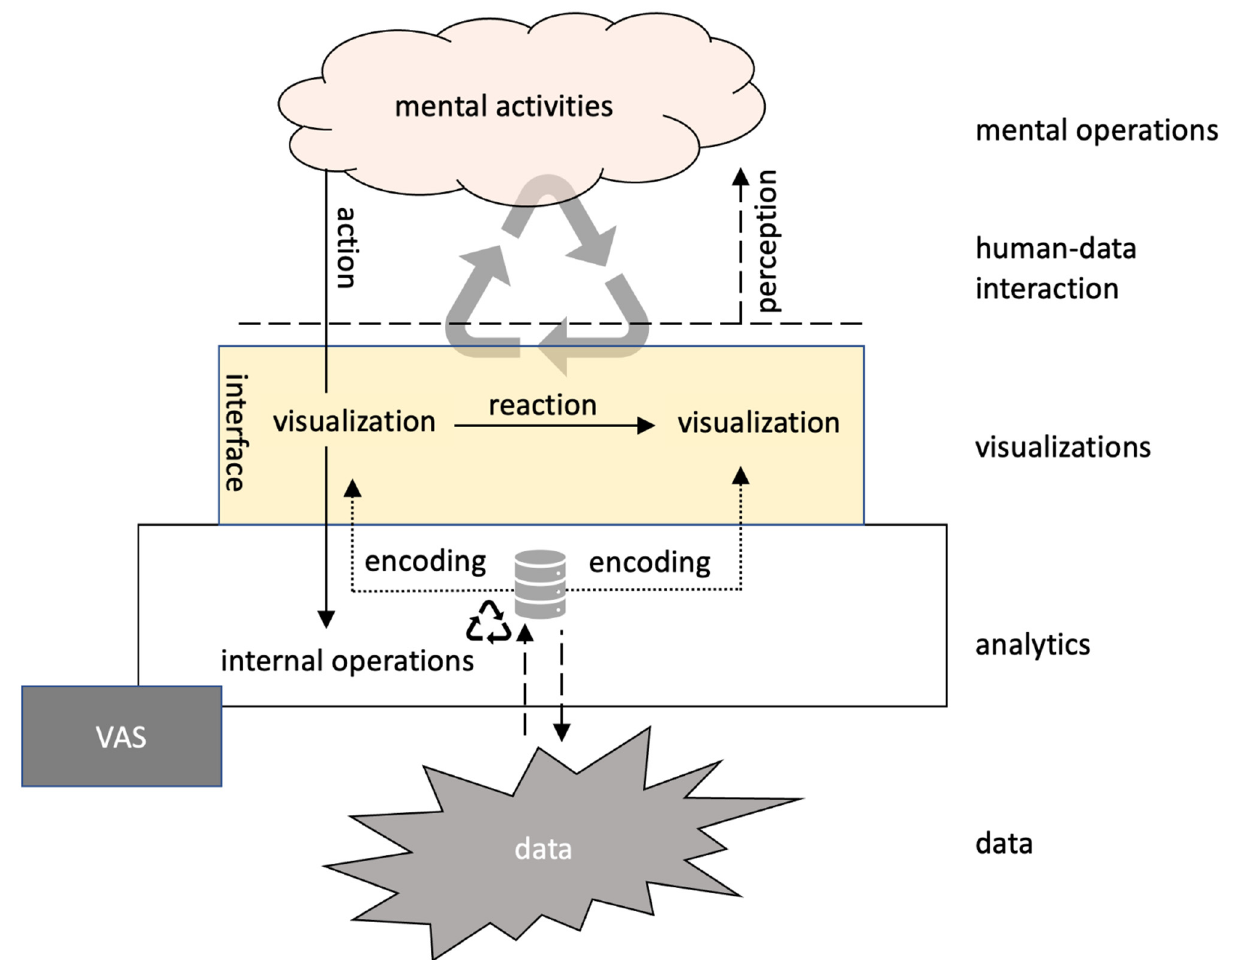
Figure 1. Sense-Making Loop (adapted from [19])